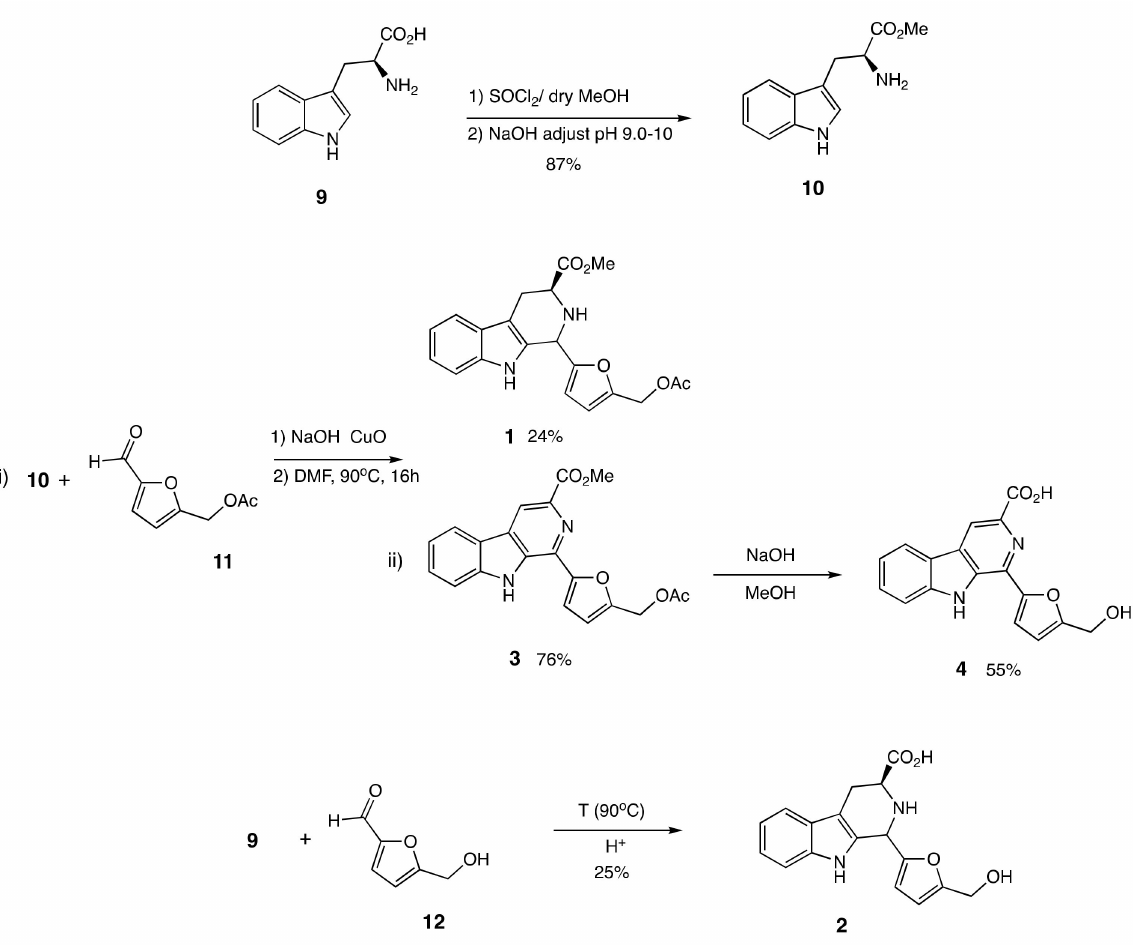
Figure 3. Cytotoxicity and lipotoxicity of 1 – 8 in HepG2 cells. The cytotoxicity (CC 50 ) was expressed as the concentration at which 50% of cells died in DMEM condition without fatty acid ( − OA). The lipocytotoxicity (LC 50 ) was expressed as the concentration at which 50% of cells died, especially in DMEM condition loaded with fatty acid